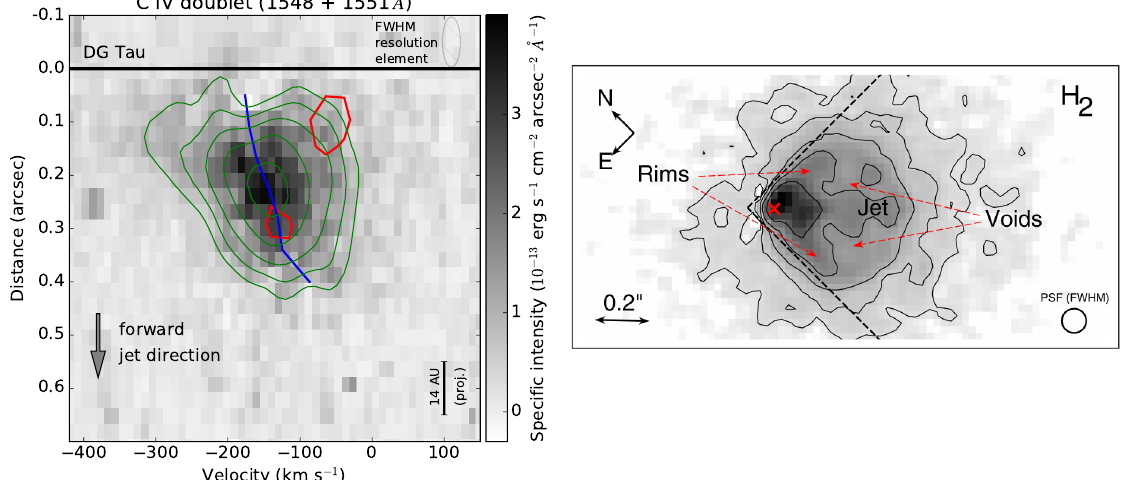
Figure 11. Left : Position-Velocity diagram for the C IV emission of the DG Tau jet. The red contours indicate emission components seen in traditional tracers like [O I ]. Note that there is no emission at the stellar position and all C IV emission originates within the jet. From Schneider et al. [34]. Right : Image of UV-H 2 of DG Tau. Reproduced with permission c ESO. (cid:13)